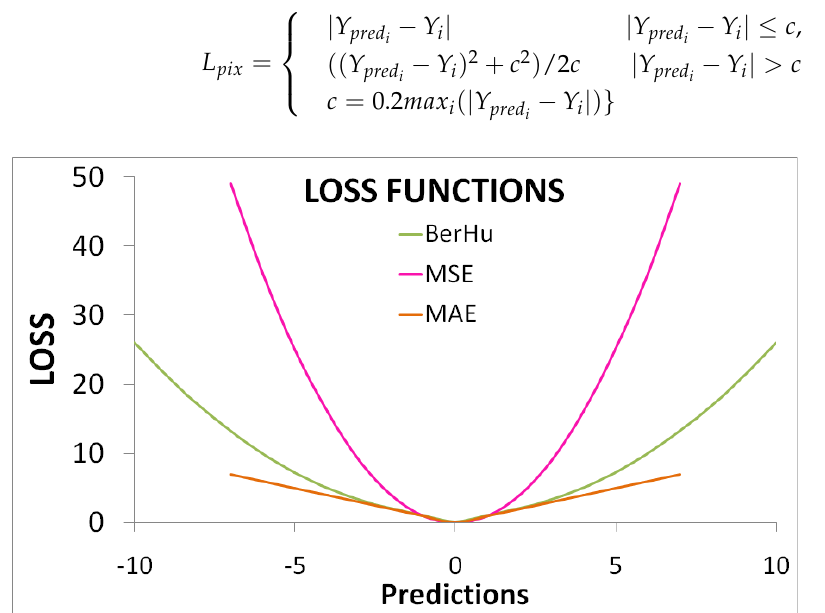
Figure 10. A comparison between MAE, MSE, and BerHu functions. The depth map needs parameters to define the image structure and object features other than pixel–wise errors. This information comes from interdependent neighboring pixels [49]. The image structure is constructed by the Structural Similarity Index